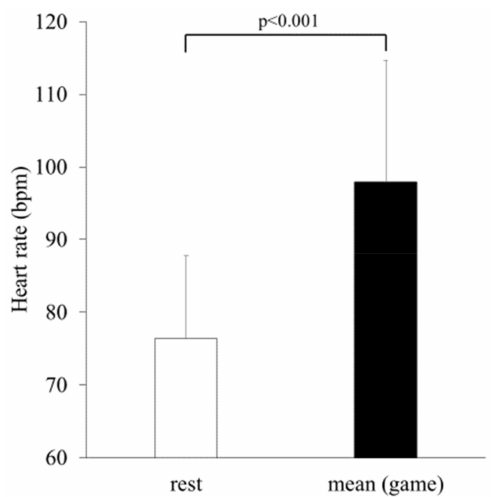
Figure 4. The rest and mean HR while playing esports ( n =